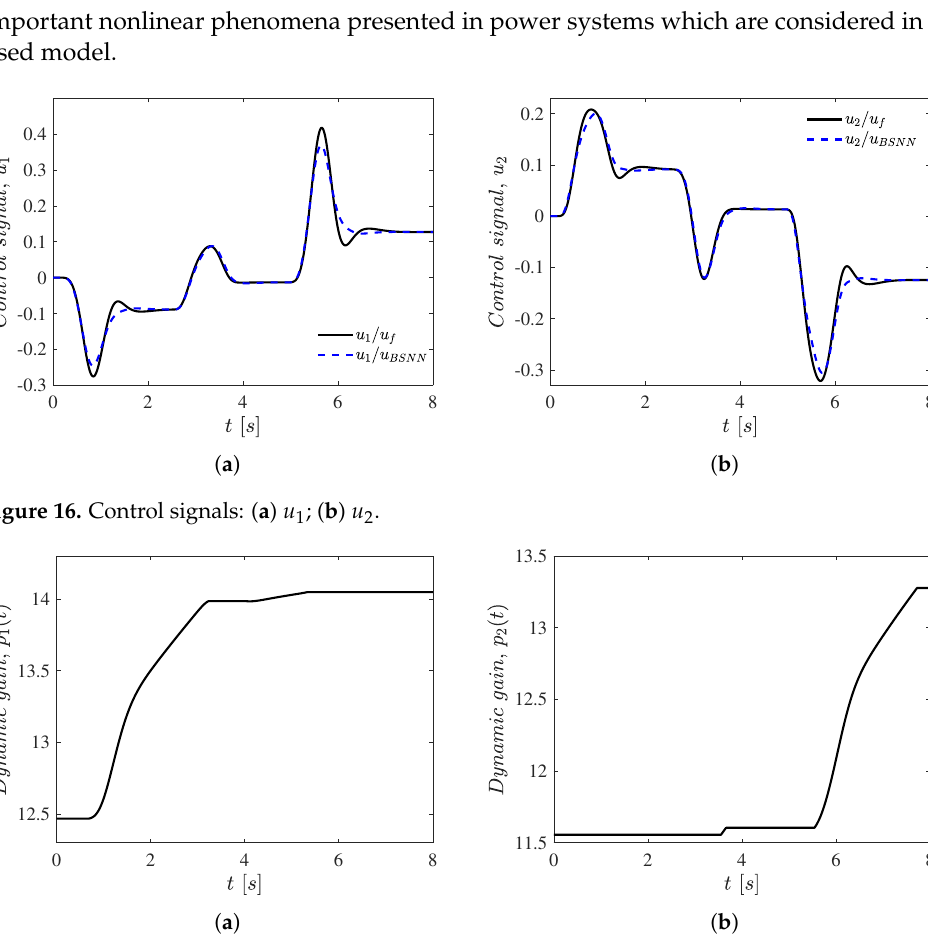
Figure 17. Evolution of the parameter p for the control scheme of each generator: ( a ) p 1 ; ( b ) p 2